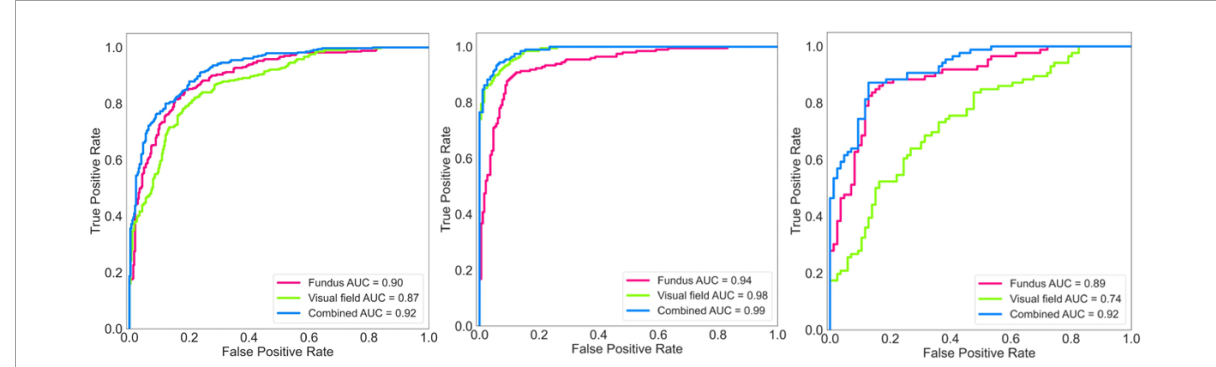
FIGURE3 Receiver operating characteristic (ROC) curves of the deep learning model for diagnosing glaucoma. Left: ROC of the model for diagnosing glaucoma based on the discovery dataset. Middle: ROC of the model for diagnosing glaucoma based on the independent validation dataset. Right: ROC of the model for diagnosing glaucoma based on an early glaucoma subset.